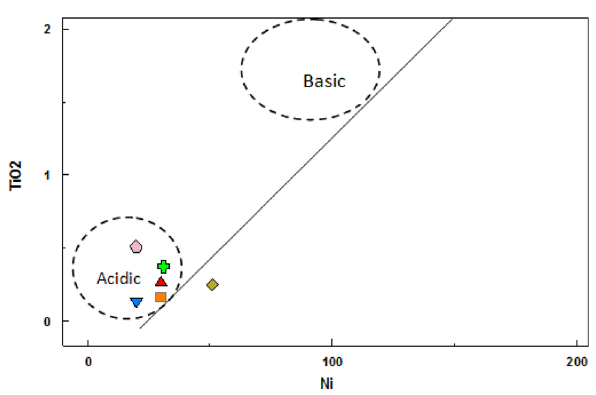
Fig. 6 Provenance diagram of TiO 2 versus Ni in coal samples (Floyd et al. 1989)